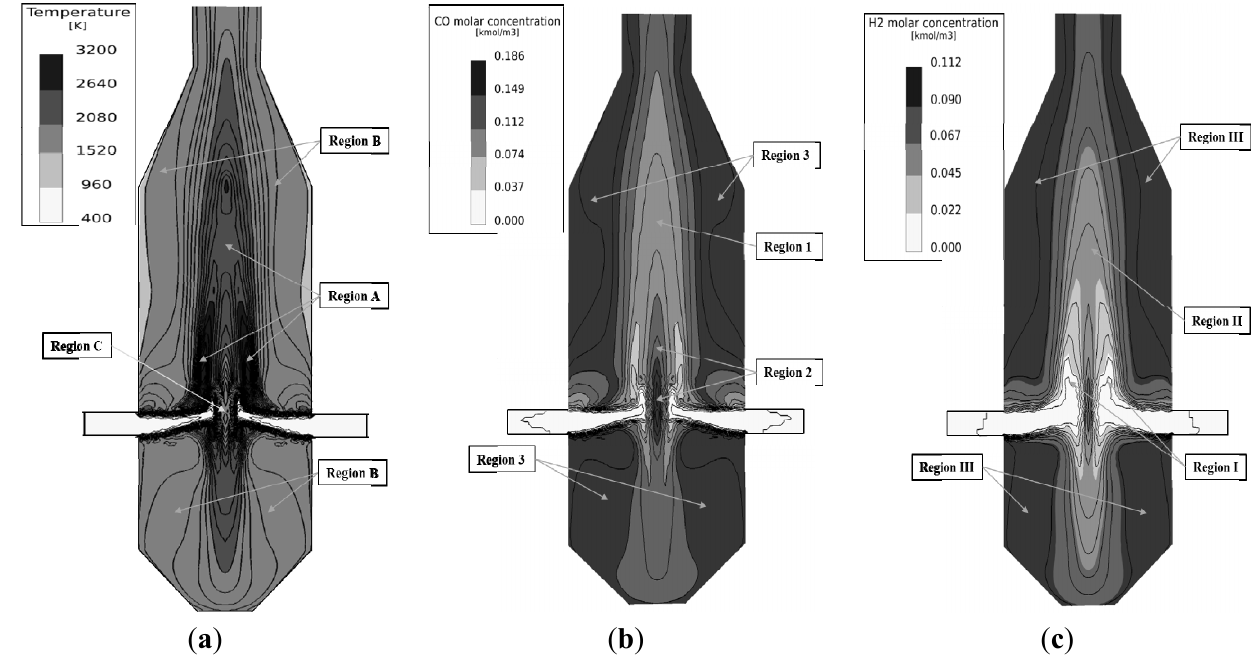
( a ) ( b ) ( c ) Figure 4. Distributions of temperature, CO, and H 2 molar concentrations. ( a ) Temperature; ( b ) Molar concentration of CO; ( c ) Molar concentration of H 2 .